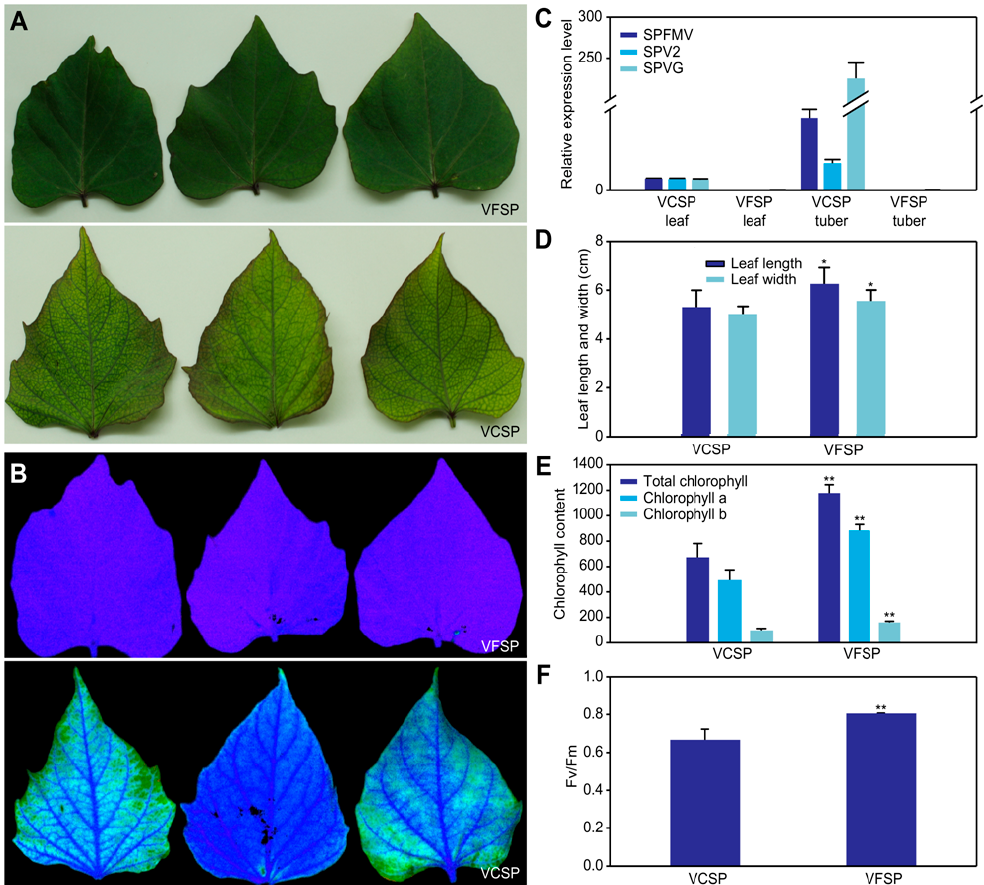
Figure 1. Phenotypes and growth indexes of sweet potato plants infected (VCSP) and non-infected (VFSP) leaves. ( A ) Phenotypes of VCSP and VFSP leaves. ( B ) Fluorescence images of VCSP and VFSP leaves. ( C ) Three virus genes were not detected in leaf and tuber of sweet potato. ( D ) Length